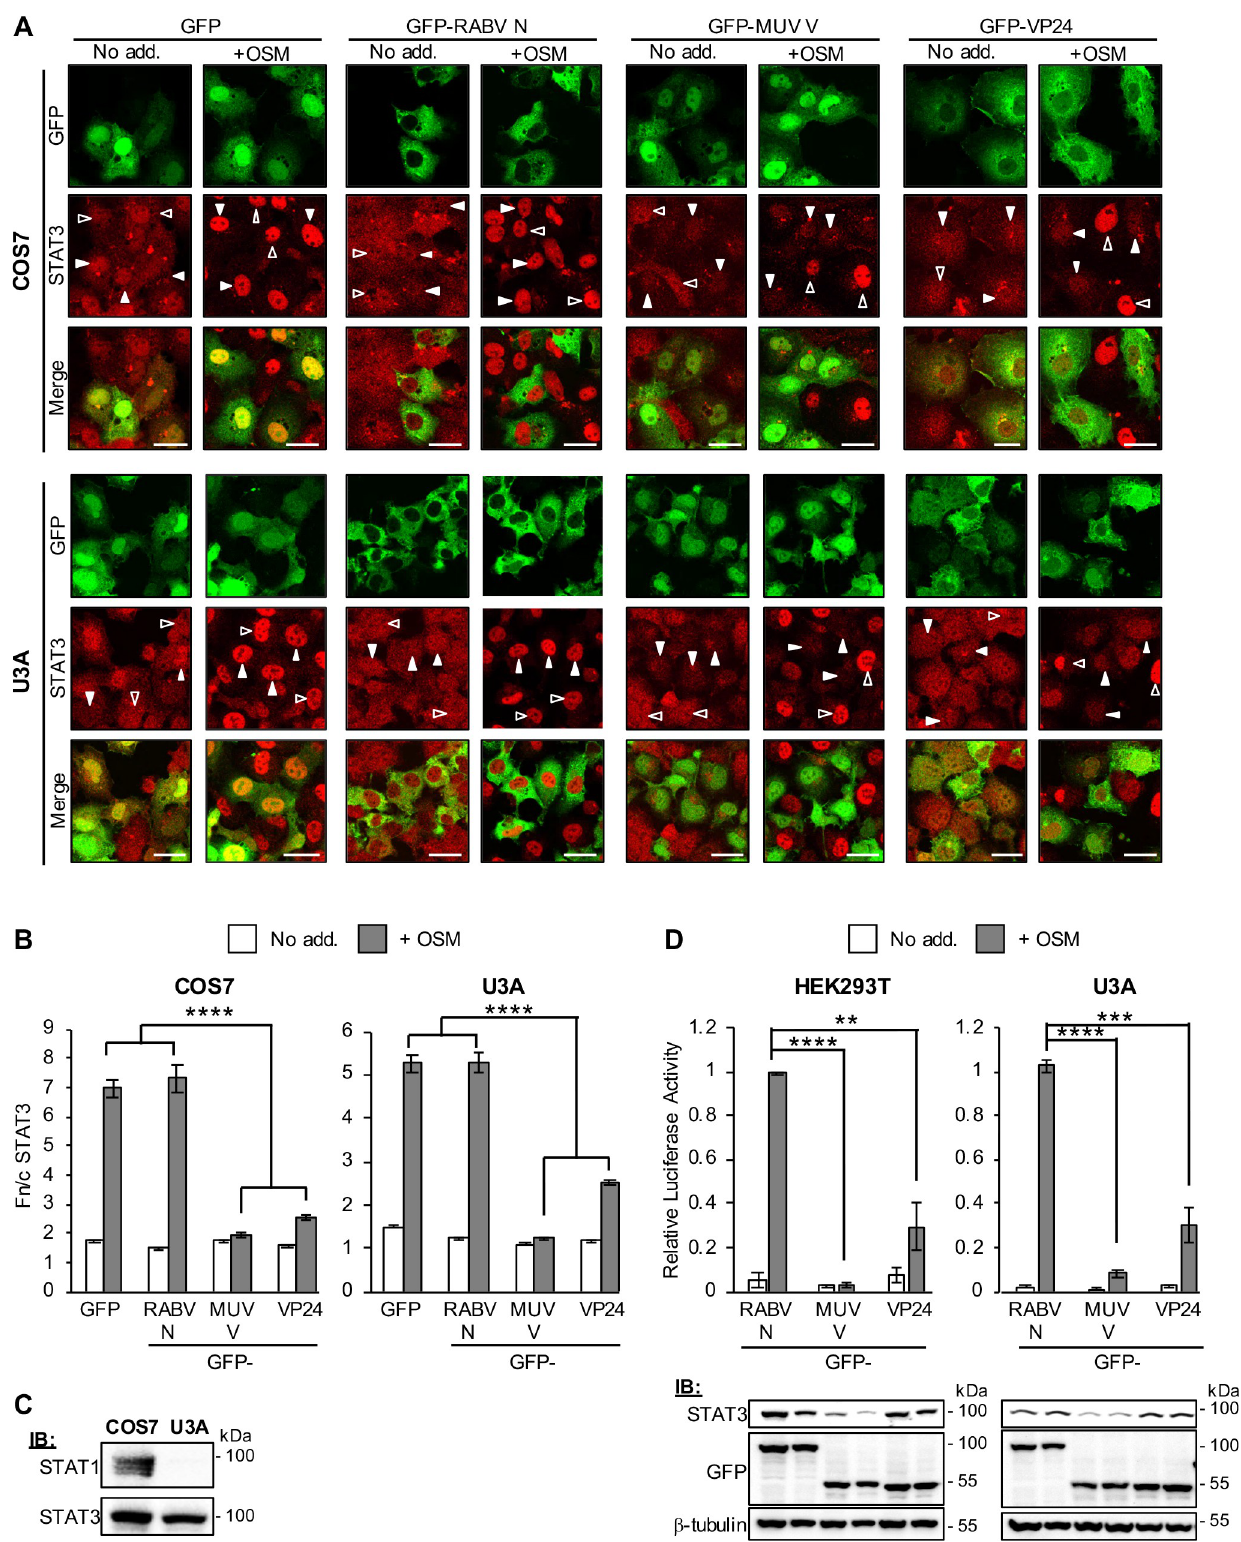
Fig 4. EBOV VP24 antagonises STAT3 independently of STAT1. (A, B) COS7 (upper panel) or U3A (lower panel) cells transfected to express the indicated proteins were treated 24 h post-transfection with or without OSM (10 ng/ml, 15 min) before fixation, immunofluorescent staining for